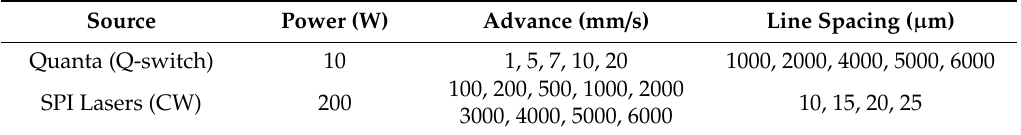
Table 3. Values of the explored PFA coating laser stripping tests on EN AW5754 aluminum substrates.